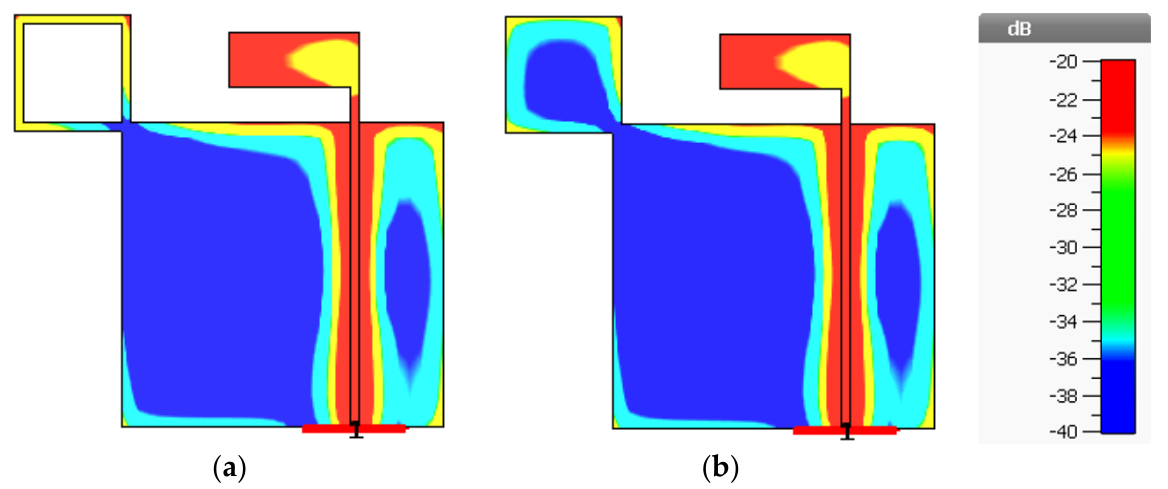
Figure 10. The coupling effect between the inverted L-shaped radiating patch and the adjoining branch at the center frequency of 1.5 GHz and 0 ◦ phase: ( a ) Antenna II (square ring branch), ( b ) Antenna III (solid square branch).